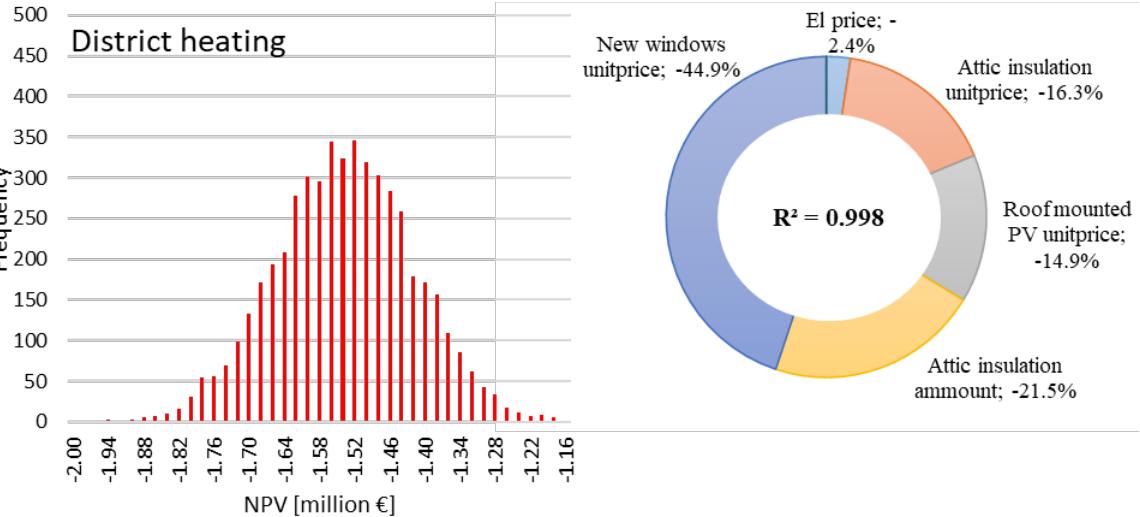
Figure A1. Left: histogram representation of resulting NPV for low district heating unit cost. Right: resulting share of regression coefficients and R 2 value of the linear approximation. Table A1. Regression parameters for calculation model with District Heating. Regressions for all three cost levels of DH are identical.